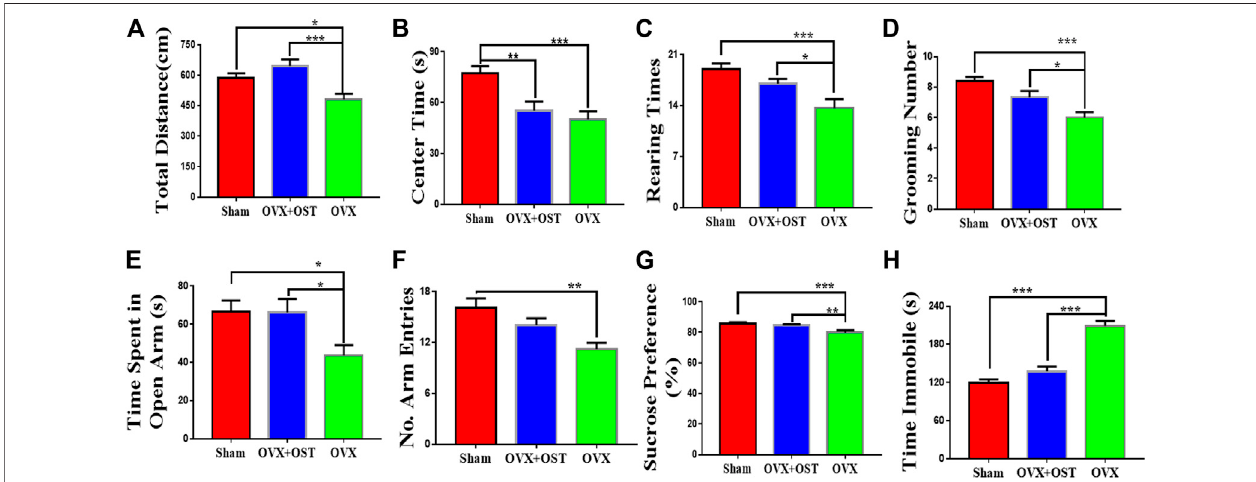
FIGURE 2 | Effects of OVX and OST on anxiety-like and depression-like behaviors in mice (A – F) (A) The open fi eld test (OFT), OVX mice showed decreased exploratory activity compared to sham controls, and OST reversed this decrease (B) OVX signi fi cantly decreased the time spent in the center of the open fi eld but OST treatmentdidnotreversethesedecreases. (C,D) OVXreducedrearingandgroomingnumbersintheOVXgroup,andthesedecreaseswerereversedbyOSTtreatment. OVXmicespentsigni fi cantlesstimeintheopenarmsandmadefewerarmentries (E,F). TreatmentwithOSTincreasedthetimespentintheopenarmsbutdidnot increase the number of arm entries in the elevated plus maze test. (G) In the sucrose preference test (SPT), OVX caused a reduction in the sucrose consumption but the treatmentwithOSTreversedthiseffect. (H) MiceintheOVXgroupexhibitedanincreaseinimmobilitytimeintheFSTwhilethisincreasewasreversedbyOSTtreatment. Data are represented as mean ± SEM ( n (cid:1) 15). * p < 0.05; ** p < 0.01; *** p <